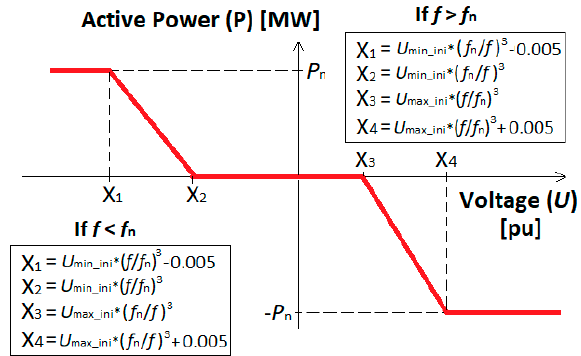
Figure 9. Real-time smooth frequency adaptive PU -droop without specific frequency and voltage limits for activation e.g., for BESS unit.